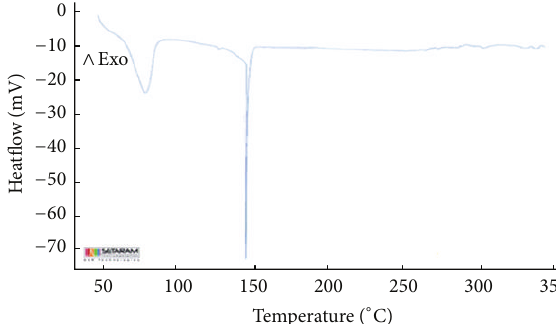
Figure 8: DSC curve of 2C 13 H 12 N 2 O ⋅ H 2 O.